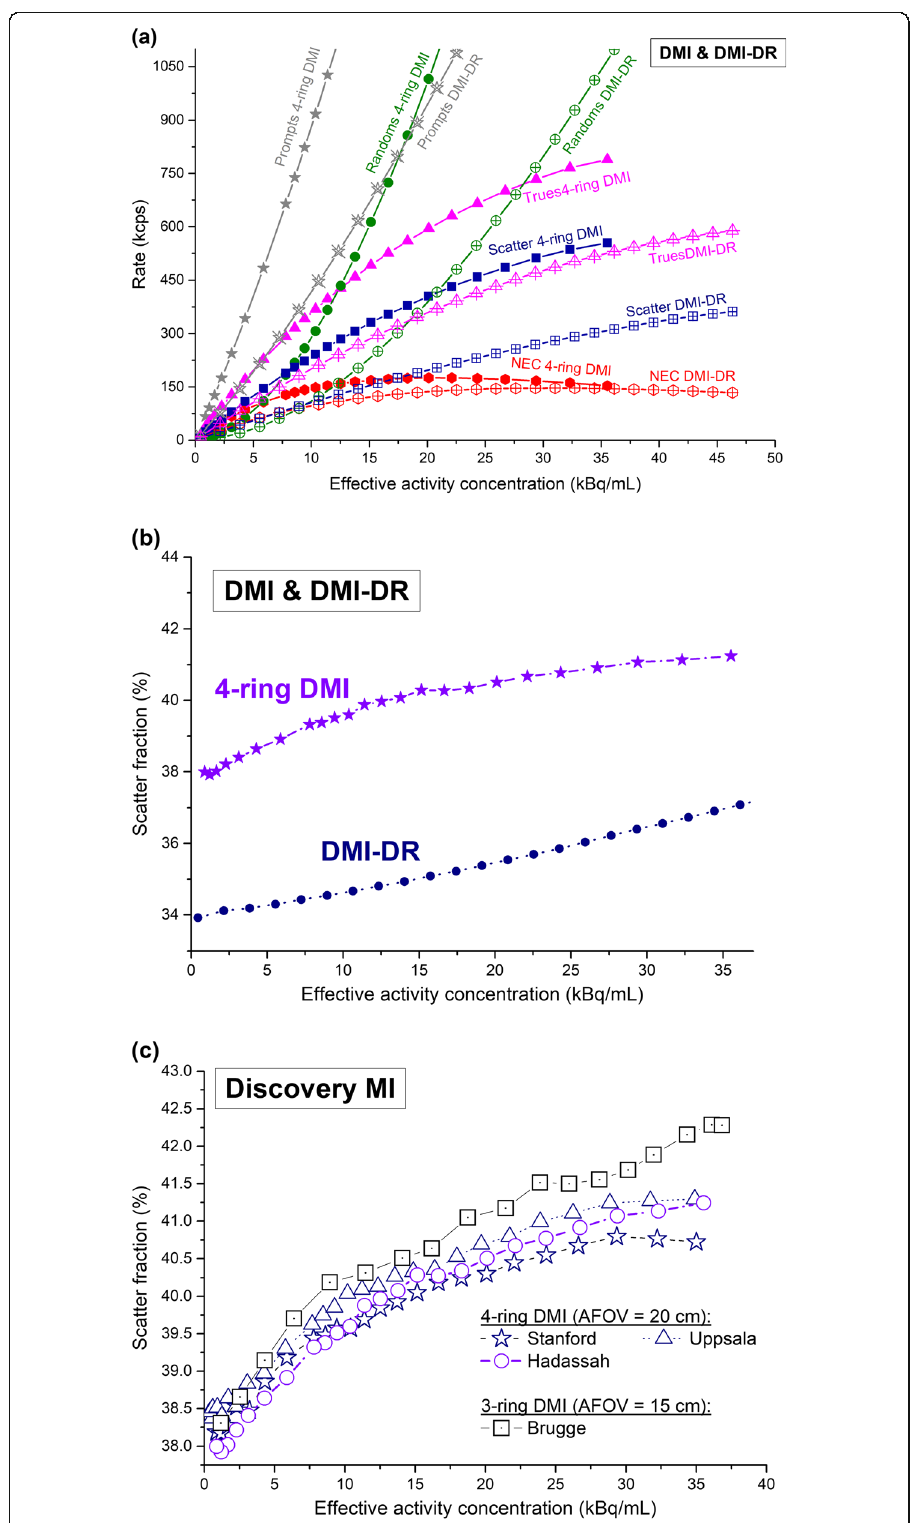
Fig. 4 (See legend on next